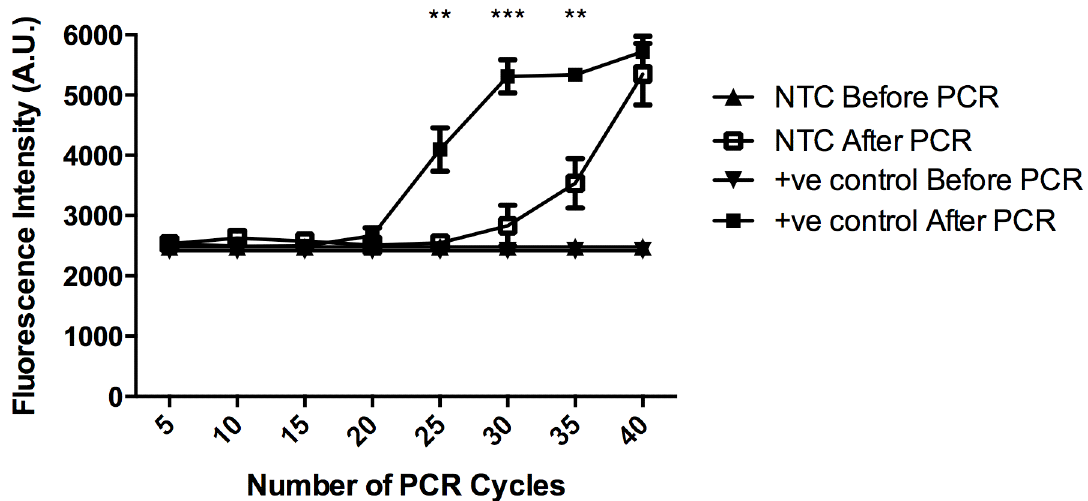
Fig 2. Optimization of number of PCR cycles. DANP-anchored RT-PCR is carried out with and without the presence of CHIKV RNA template and the fluorescence intensity is measured after every 5 PCR cycles from both before and after PCR reactions. The fluorescence intensity starts to increase significantly after 20 cycles when CHIKV RNA is present and reaches saturation after 30 cycles, while that of NTC also starts to increase slowly from 25 to 30 cycles and become more obvious afterwards. As a result, the maximum difference in fluorescence intensity can be achieved after 30 cycles of PCR reaction. Data are shown as means SEM of five experiments. *** P < 0.001, ** P < 0.01 by multiple t-test.